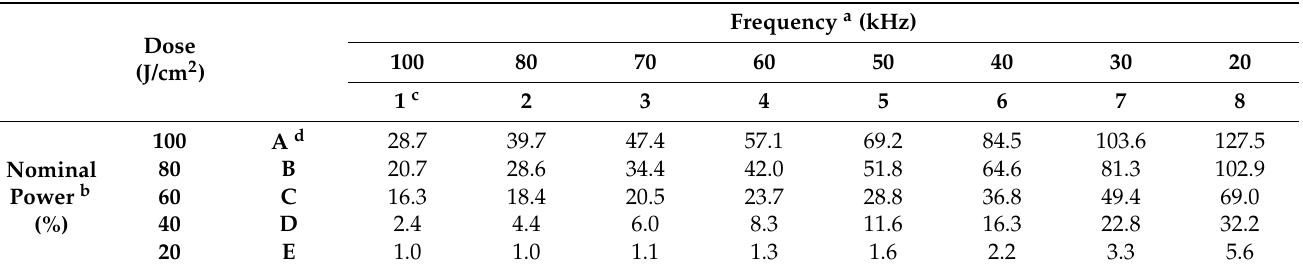
Table 1. Dose values as a function of the frequenccy of the laser pulse and percentage of the nominal laser power set in the